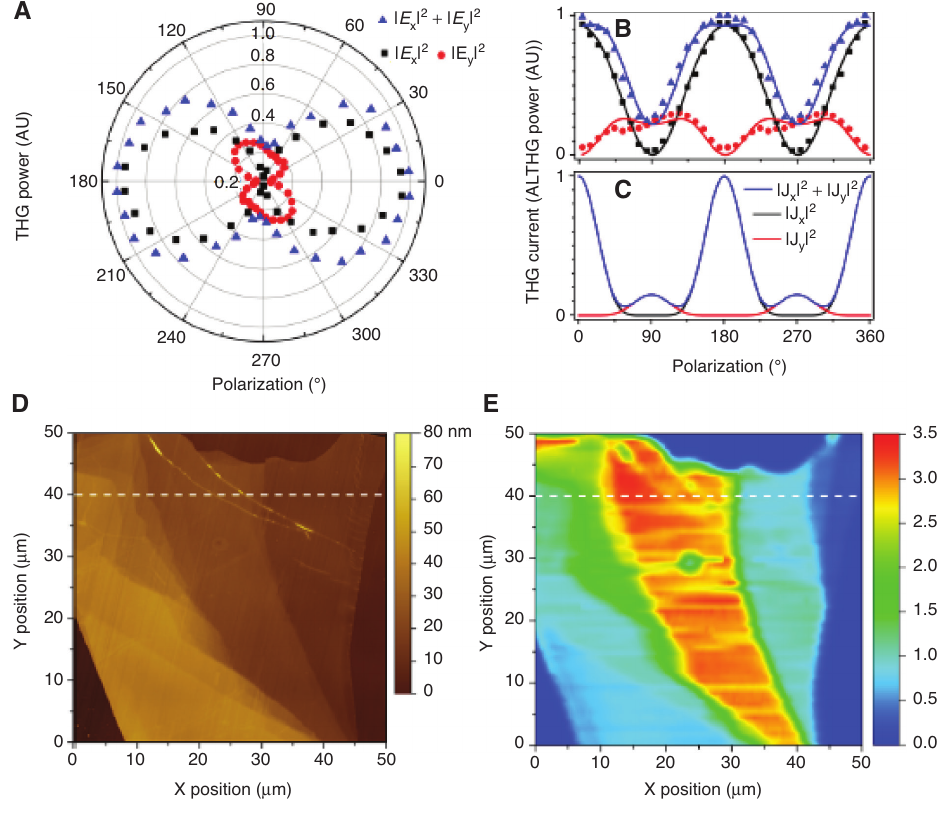
Figure 8: Anisotropic THG in multilayer BP [128]. (A) Dependence of THG on the incident polarization. Zero degrees corresponds to the x -axis (armchair direction) of the BP crystal. (B) The same data as in (A) with theoretical fits to the intensity polarized in the x (black squares) and y (red dots) directions. Blue triangles correspond to the total intensity. (C) Calculated THG current induced in BP. (D) Atomic force microscopy image of a BP flake containing many layers with various thicknesses. (E) Position-dependent THG signal measured by scanning the position of the beam relative to the sample. Different thicknesses can be resolved via contrast in the THG